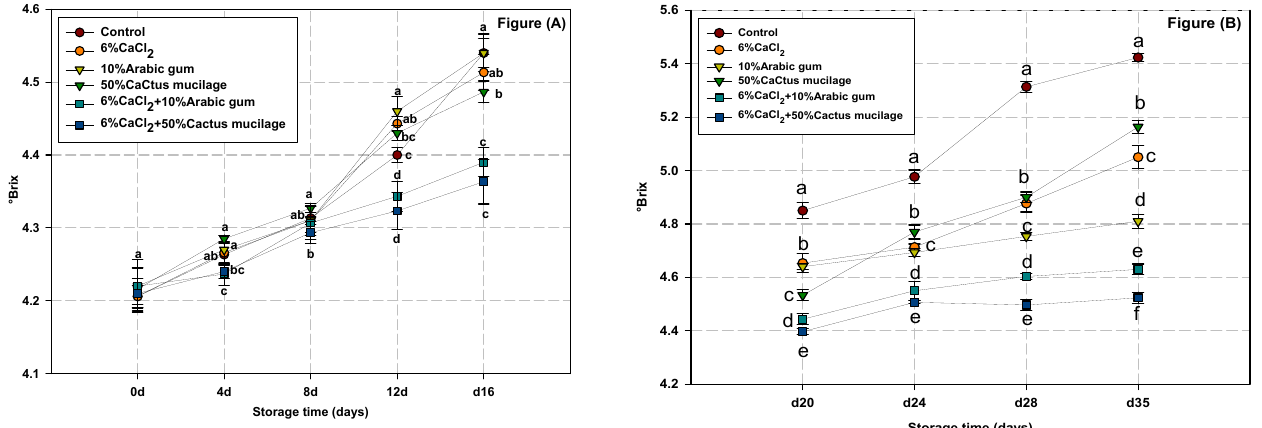
Fig. 5 (A, B): Effect of natural substance combination with CaCl 2 on the total soluble solid (°Brix) of tomato fruits at cold storage (10 °C). Means followed by the same letter are not significantly different (Duncan’s multiple range test, P > 0.05)